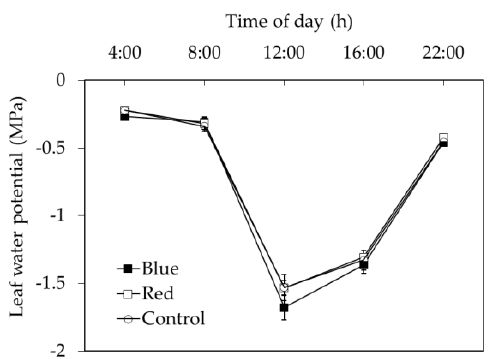
Figure 7. Daily course of leaf water potential in ‘Fuji’ apple potted trees grown under blue ( ■ ), red (□), and white control ( ○ ) nets. Each value represents the mean ± standard error (SE) of 5–10 leaves.